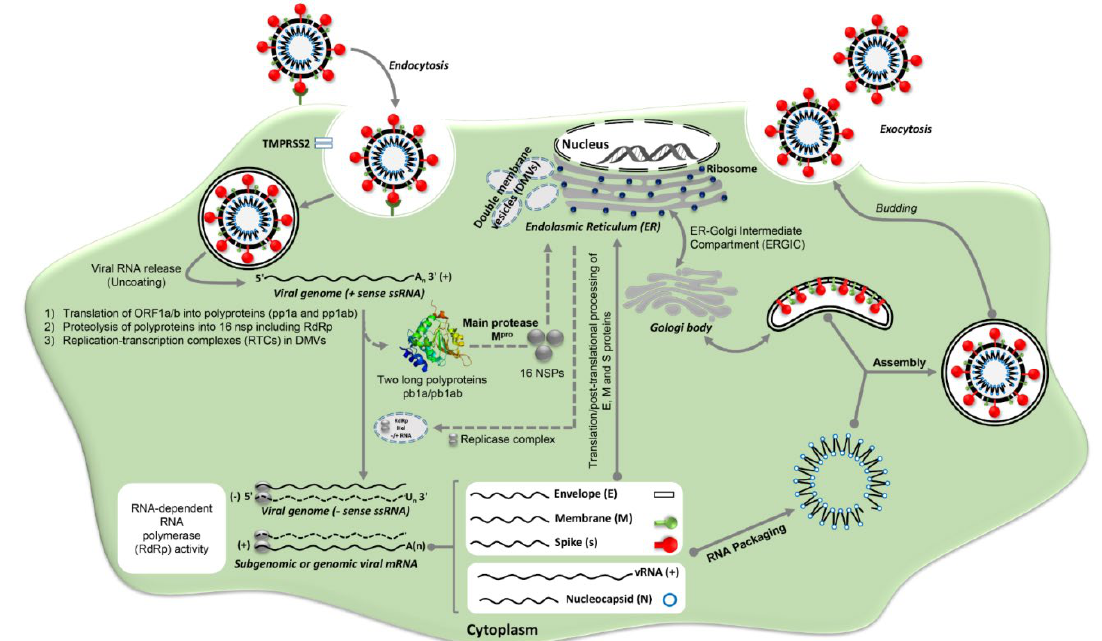
Figure 1. The schematic diagram illustrates the life cycle of coronavirus. The spike (S) protein of coronavirus commences infection “endocytosis” via recognizing the cellular ACE2 receptors and binding to it with its receptor-binding domain (RBD) in the S1 subunit. Following the viral genome (+ssRNA) into the host cell cytoplasm, two long polyproteins, namely pp1a and pp1ab, are translated from viral ORF1a and ORF1ab transcripts. The pp1a and pp1ab are further cleaved into 16 essential nonstructural proteins (NSPs). Necessary elements to the viral genome replication/transcription (e.g., nsp-7, nsp-8, and nsp-12) are congregated as RNA replication–transcription complexes (RTCs) inside ER-derived double-membrane vesicles (DMVs) to initiate the transcription/replication machinery for the internalized +ssRNA genome, leading to the generation of the genomic and subgenomic RNAs and their encoded viral proteins. Following the assembly of the posttranslated viral proteins and the nascent genomic RNA, the budding virion is then released from the infected host cell via exocytosis. Figure has been created by microsoft